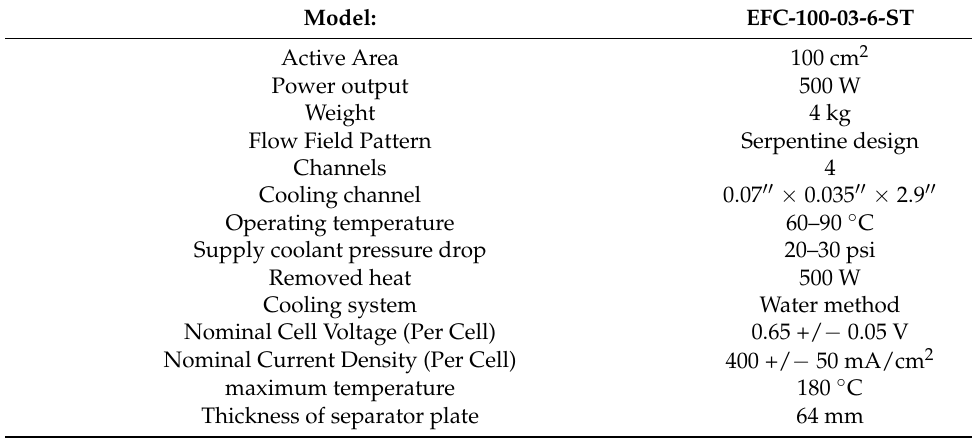
Table 1. EFC-100-03-6-ST key features and